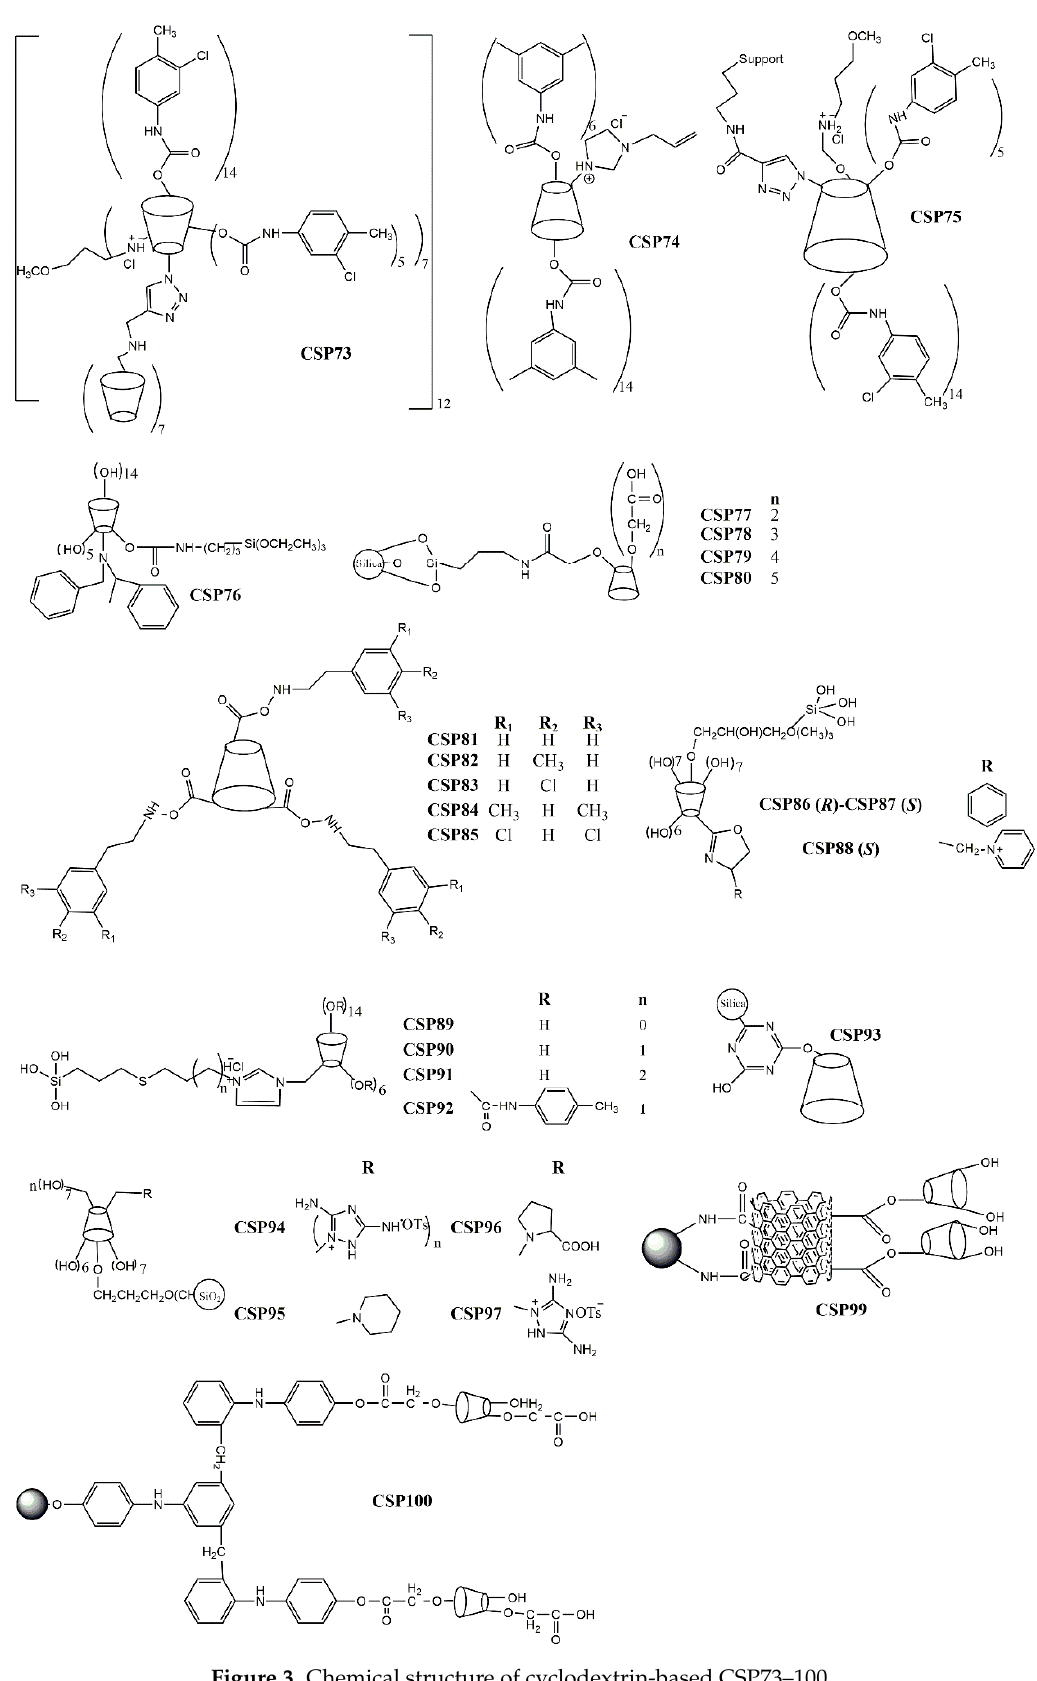
Figure 3. Chemical structure of cyclodextrin-based CSP73–100.